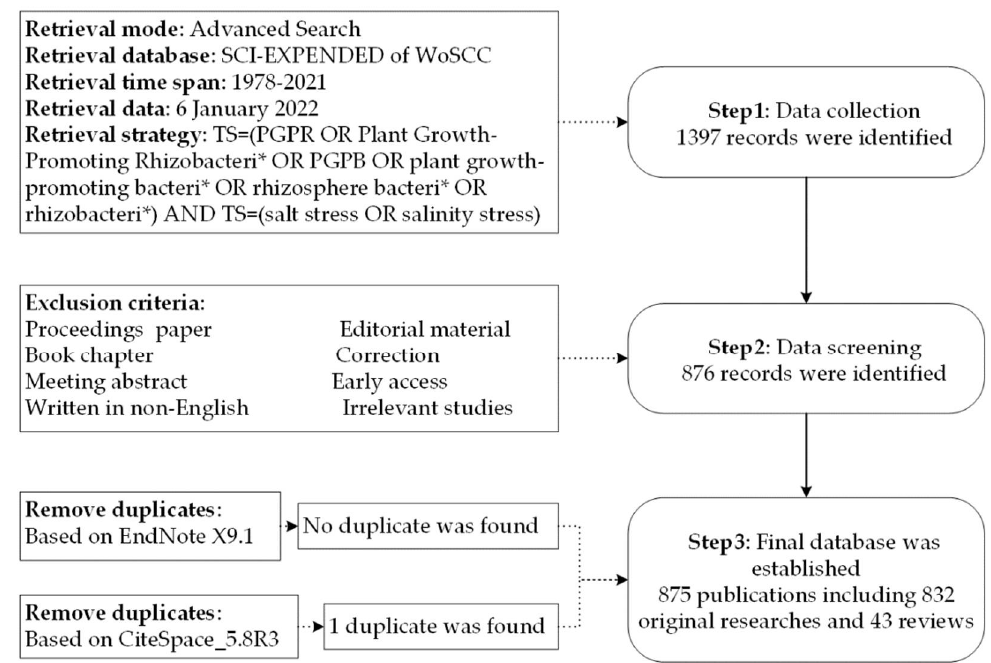
Figure 1. Flowchart of document retrieval. “*” is a wildcard and indicates any groups of characters, including blank characters.